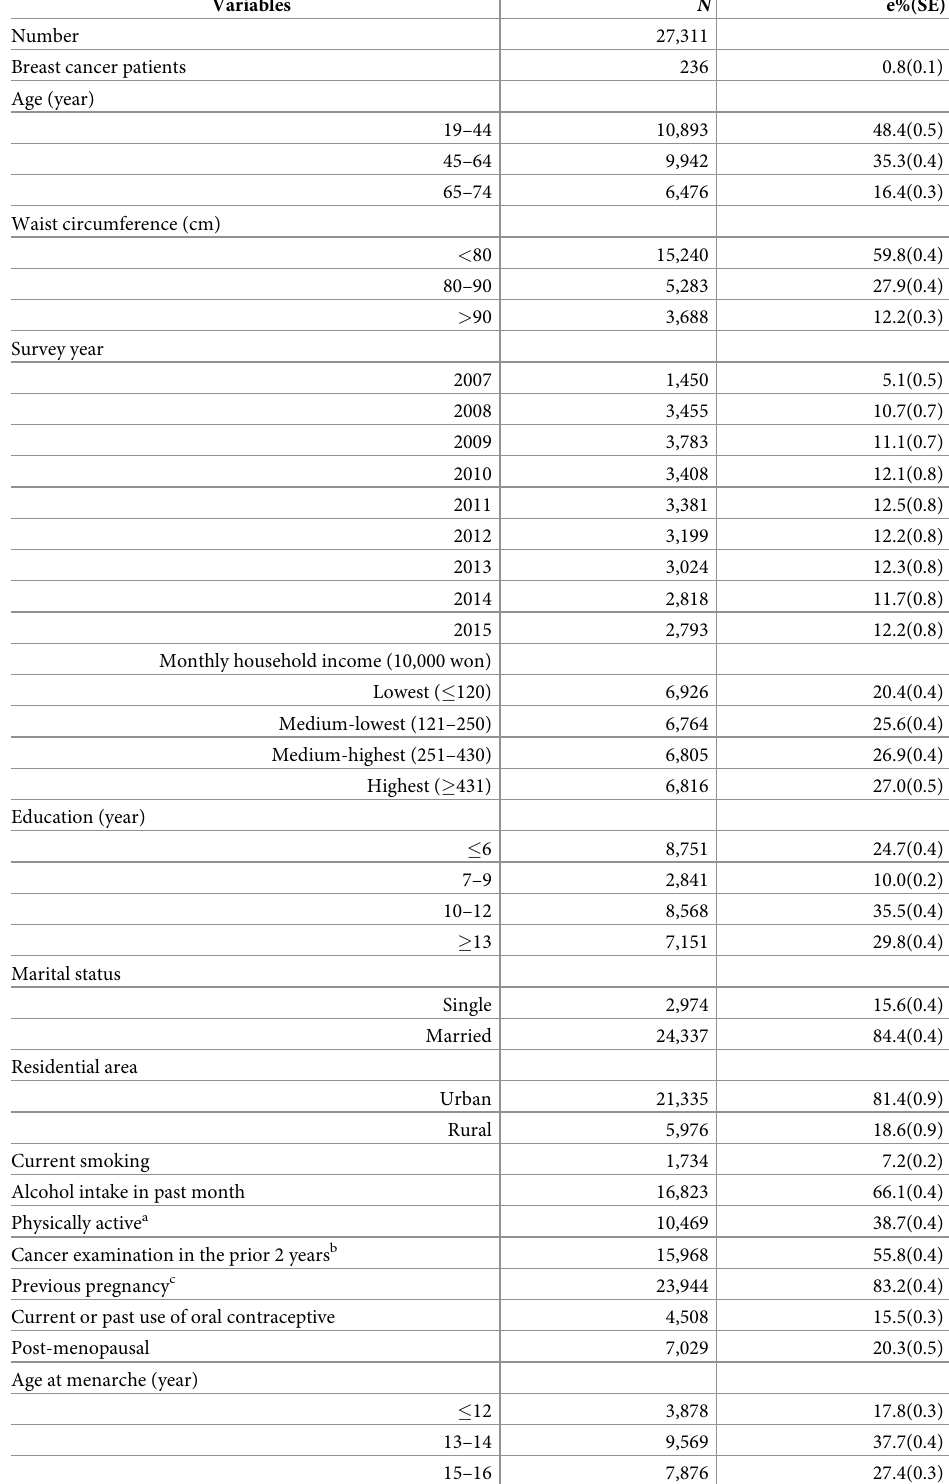
Table 1. Baseline characteristics of